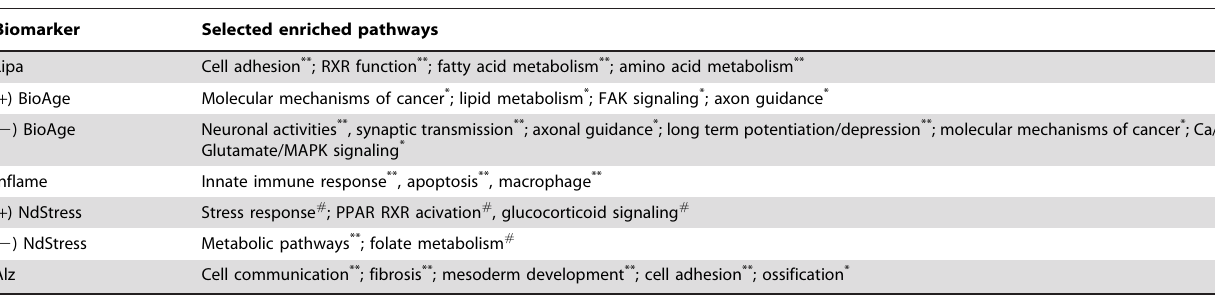
Table 2. Selected pathways that are enriched in